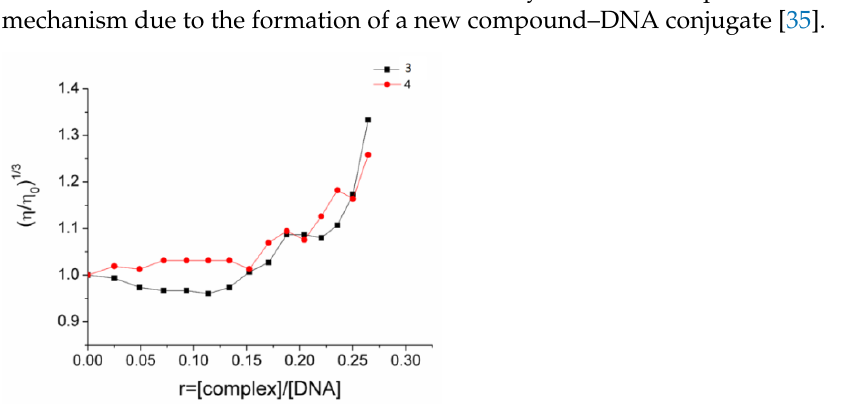
Figure 6. Relative viscosity (η/η o ) 1/3 changes in a CT DNA (0.1 mM)-buffered solution (150 mM NaCl and 15 mM trisodium citrate at pH 7.0) upon addition of increasing amounts of compounds 3 and 4 versus r = [compound]/[DNA].